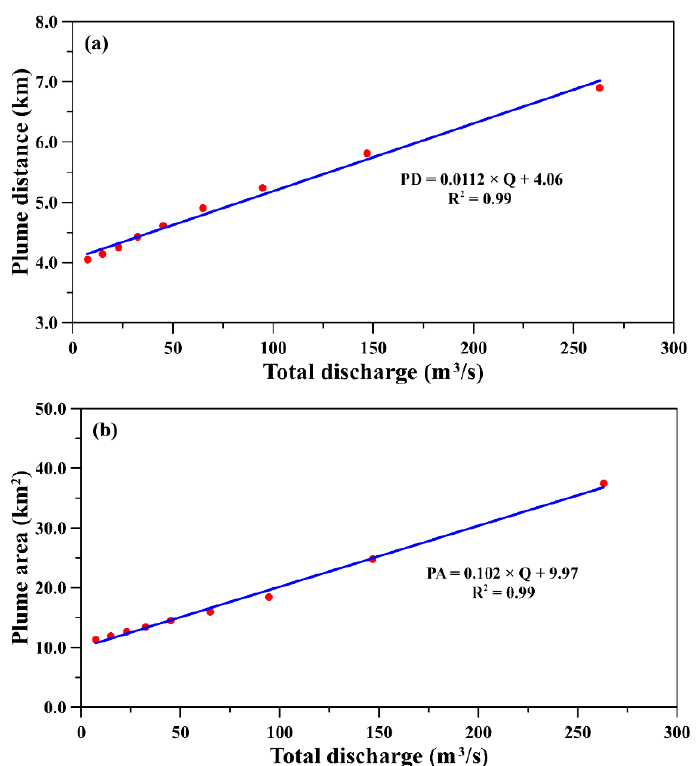
Figure 8. Correlations between ( a ) plume lengths and ( b ) plume areas and total freshwater discharges from upstream boundaries.